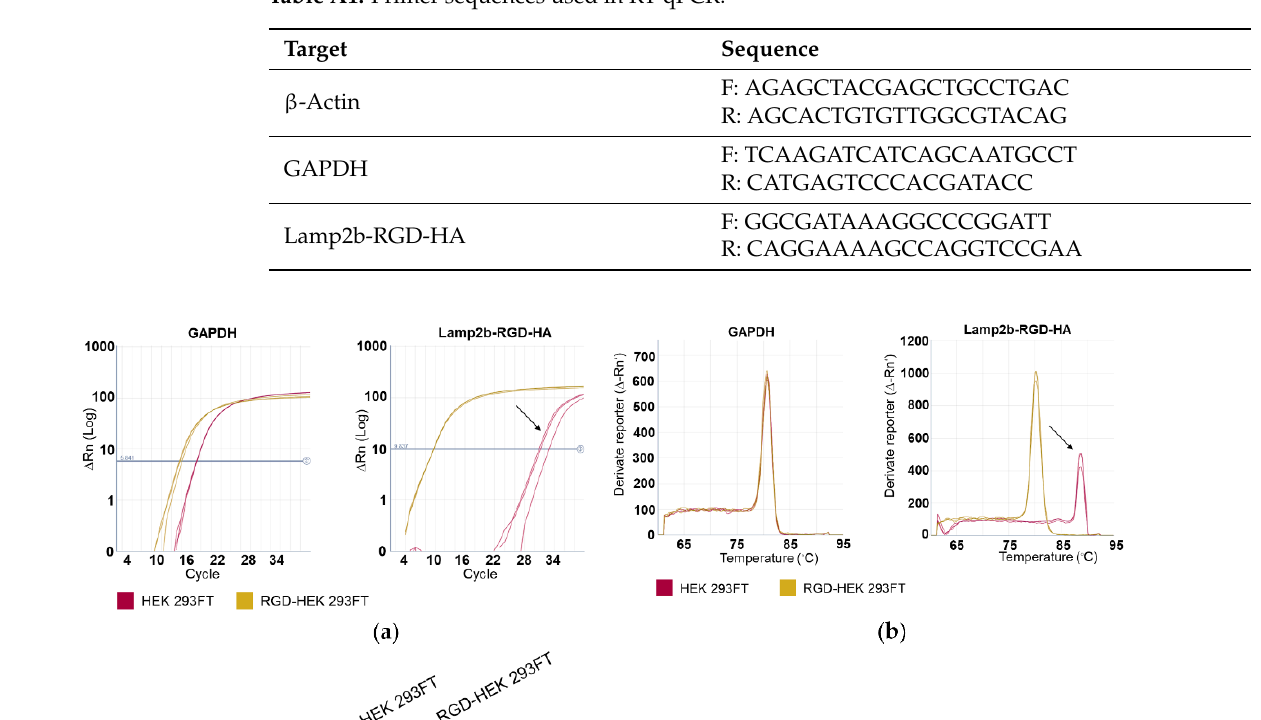
Table A1. Primer sequences used in RT-qPCR.